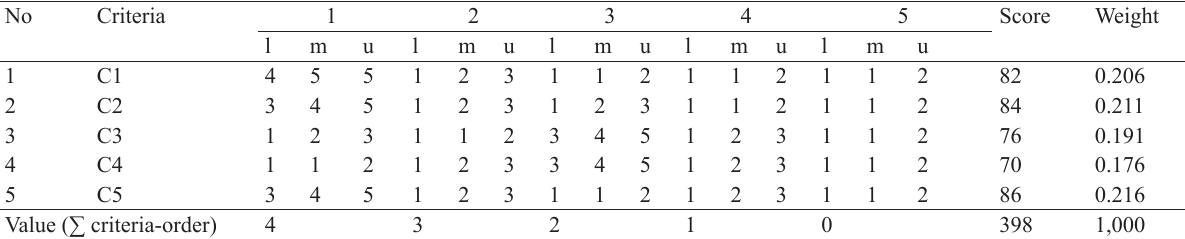
Table 7 TFN value of experts’ weighting on criteria of the fuzzy-Eckenrode method No